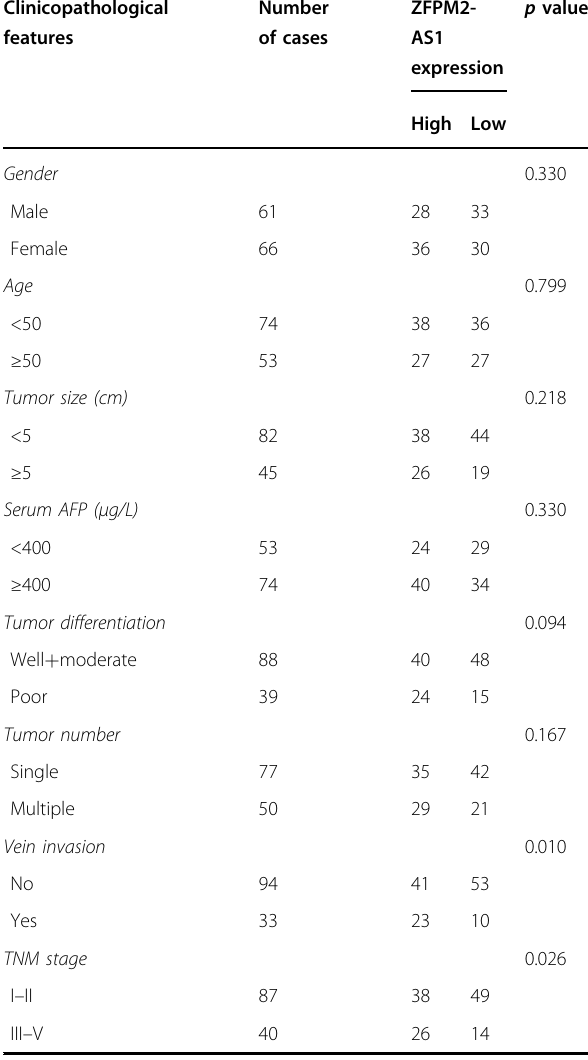
Table 1 The association between ZFPM2-AS1 expression and characteristics of patients suffering from HCC.